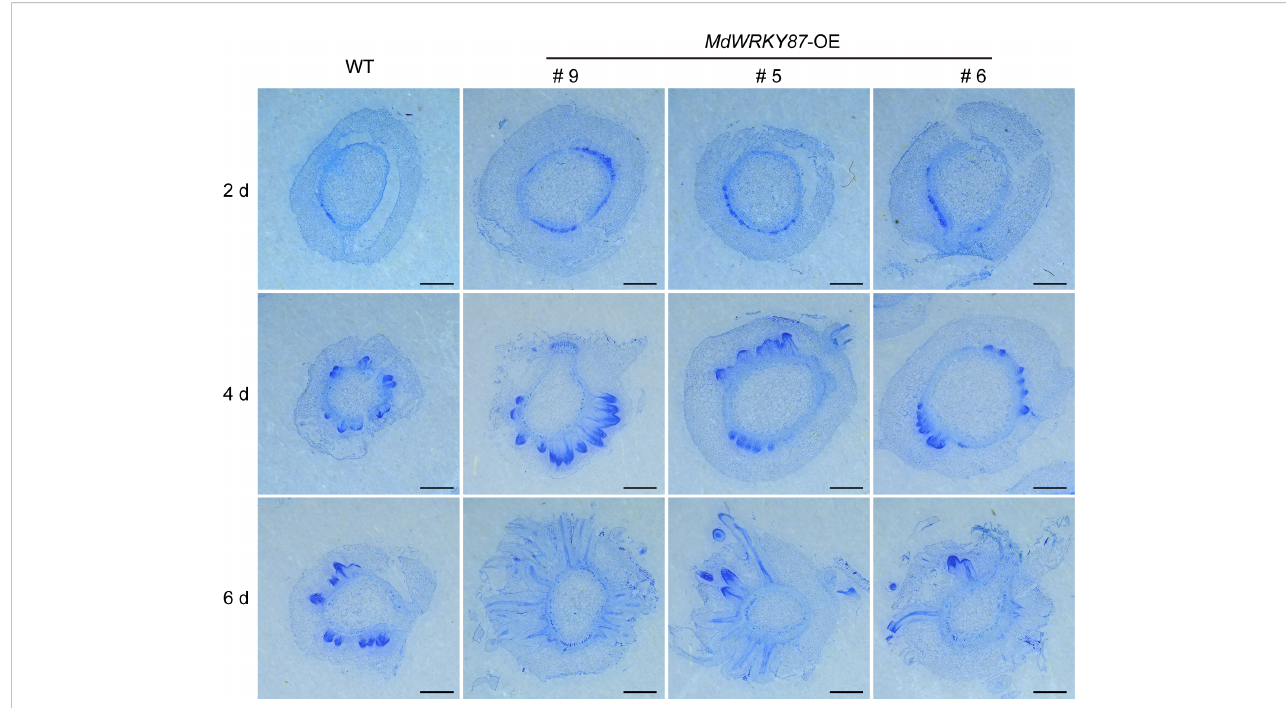
FIGURE 4 MdWRKY87 accelerates the formation of adventitious root primordium in transgenic tobacco ( N. tabacum ) plants. Cross-sections of stem bases at 2, 4 and 6 days after transplanting during adventitious root formation in WT and MdWRKY87- OE lines. Sections were stained by toluidine blue. Scale bar = 1